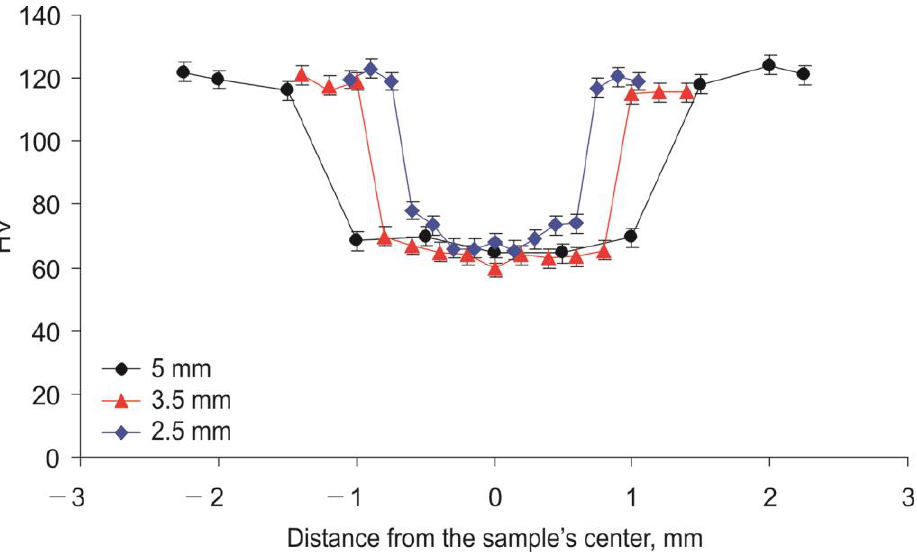
Figure 7. Microhardness value distribution in the cross section of the composite samples with different diameters.